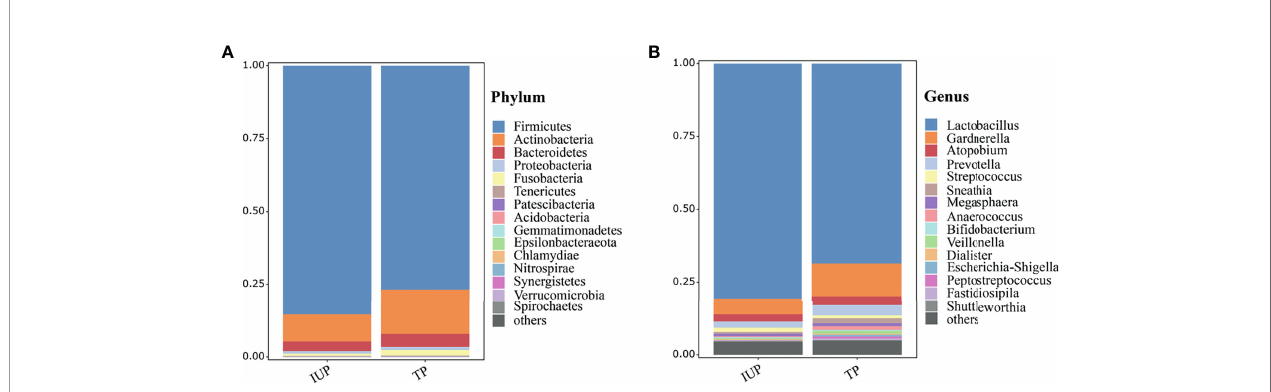
FIGURE 2 | Vaginal taxonomic pro fi les of women with IUP or TP. (A) Vaginal microbiome pro fi les of women who were con fi rmed as having IUP or TP, at phylum level; the top 15 taxa are showed in the fi gure. (B) At the gene level, the top 15 taxa are listed according to their relative abundances in the two groups.